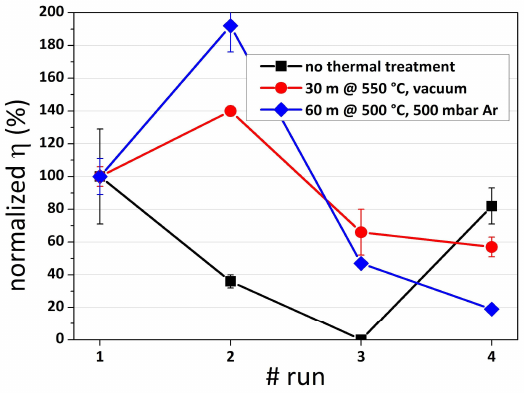
Figure 4. The normalized efficiency of the solar cells produced from the SnS raw material: untreated (black, square dots), annealed in vacuum (red, circle dots), and annealed in Ar (blue, diamond dots).